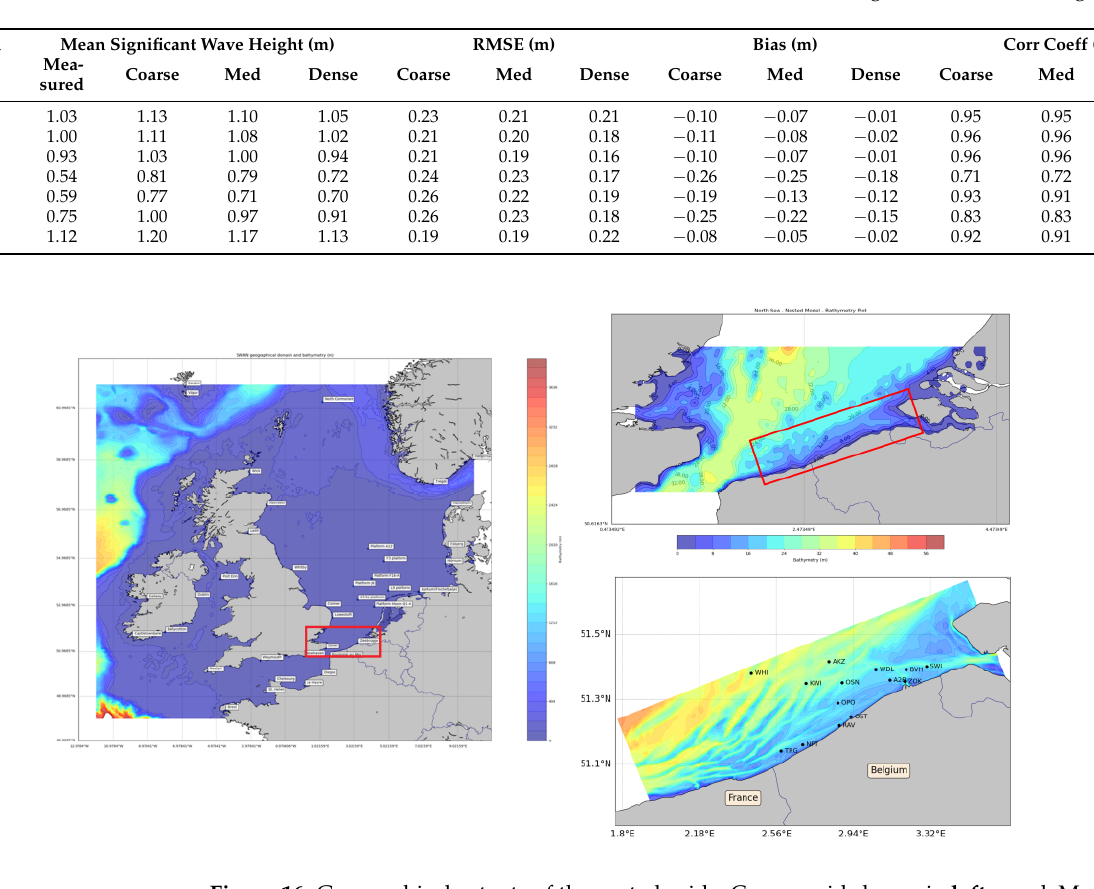
Figure 16. Geographical extents of the nested grids: Coarse grid shown in left panel; Medium grid shown in top-right panel; and the Dense grid in the bottom-right